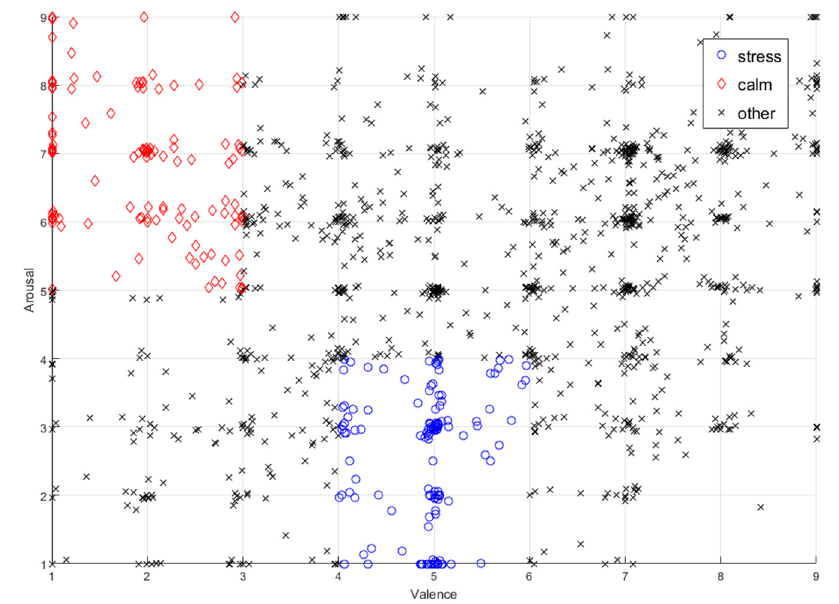
Figure 2. The result of data annotation.